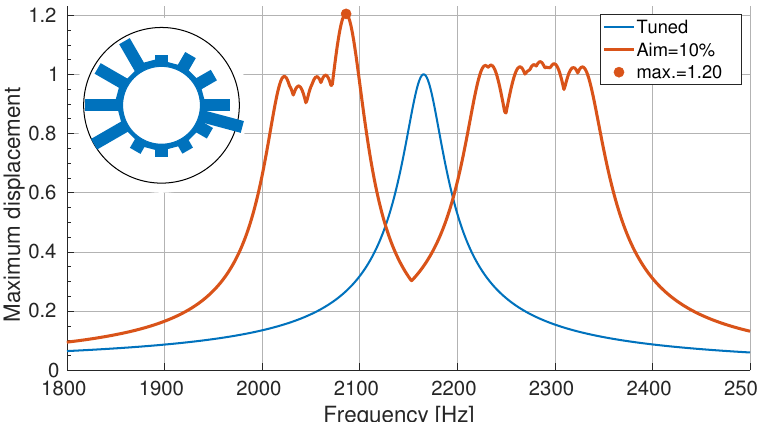
Figure 9. Frequency sweep and (inset) blade displacement at the maximum (black line corresponds to the tuned amplitude) for Aim = 10%. Rotor A, [ 1, − 1, . . . ,1, − 1,1,1 ] pattern, ξ = 10 − 2